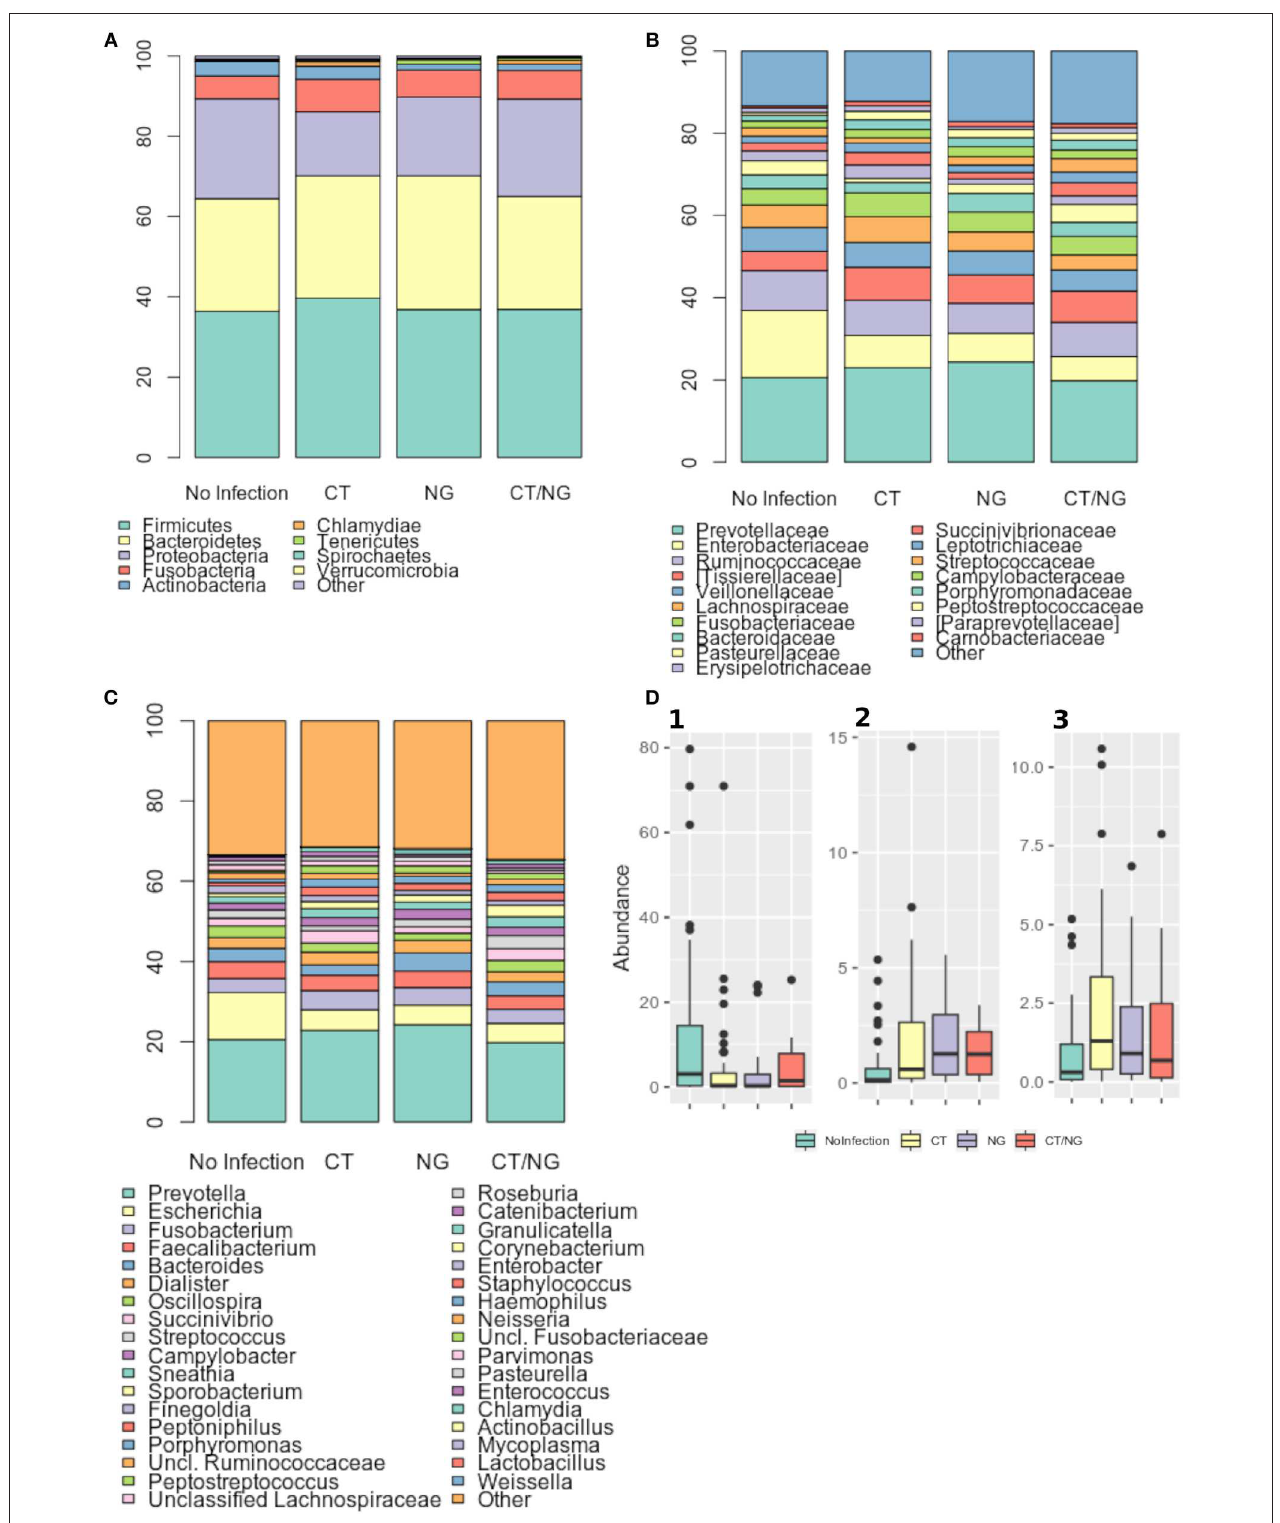
FIGURE 3 | Taxonomic composition of the rectal microbiota. Stacked bar charts of taxonomy relative abundances at (A) phylum, (B) family, and (C) genus level for the different subgroups. Only phyla, families and genera present at relative abundances > 1% on average in at least one subgroup are reported. Remaining taxa are grouped in the “Other” category. (D) Boxplots of the relative abundances of (1) Escherichia (2) Peptostreptococcus (3) Peptoniphilus genera in the different subgroups considered.